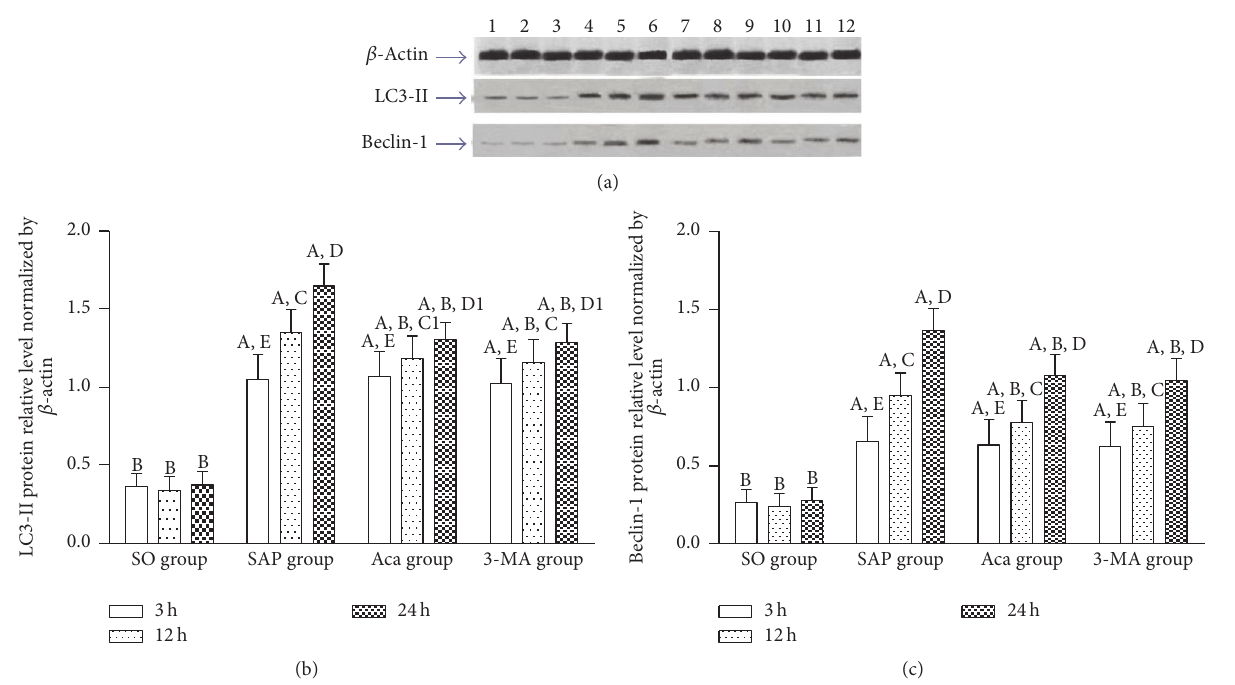
Figure 5: The protein levels of LC3-II and Beclin-1 in the pancreas tissue. (a) Representative images of western blot results; quantitative data of LC3-II (b) and Beclin-1 proteins (c). A 𝑃 < 0.01 versus SO group at the same time point; B 𝑃 < 0.01 versus SAP group at the same time point; 12h versus 3 h in the same group, C 𝑃 < 0.01 ; C 1 𝑃 < 0.05 ; 24 h versus 12h in the same group, D 𝑃 < 0.01 ; D 1 𝑃 < 0.05 ; 24 h versus 3h in the same group, E 𝑃 < 0.01 . 1: SO-3 h; 2: SO-12 h; 3: SO-24 h; 4: SAP-3 h; 5: SAP-12 h; 6: SAP-24 h; 7: Aca-3 h; 8: Aca-12 h; 9: Aca-24 h; 10: 3-MA-3 h; 11: 3-MA-12h; 12: 3-MA-24 h.